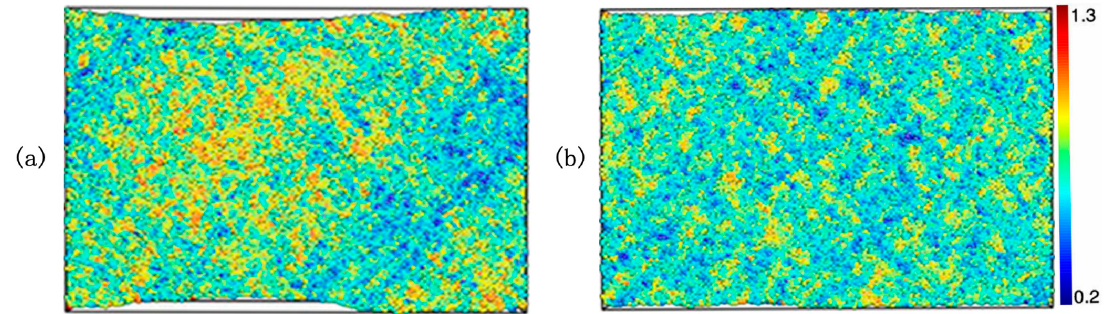
Figure 7. ( a ) The shear deformation of the samples quenched at 0 GPa at a strain of 20%; ( b ) The shear deformation of the samples quenched at 25 GPa at a strain of 20%.